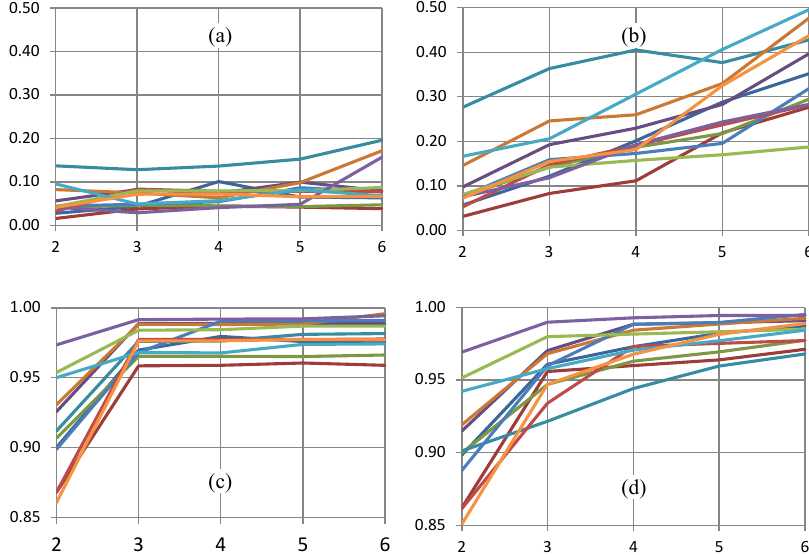
Figure 12. Mean values of storage coefficient k (day − 1 ) in the SC2 model (a) and Nash one (b) , and Nash–Sutcliffe efficiency index E f for the SC2 model (c) and the Nash one (d) versus the number of reservoirs for particular